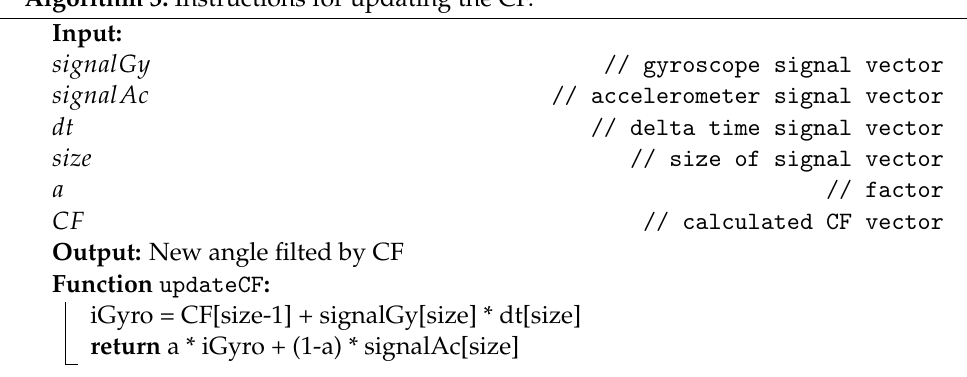
Algorithm 3: Instructions for updating the